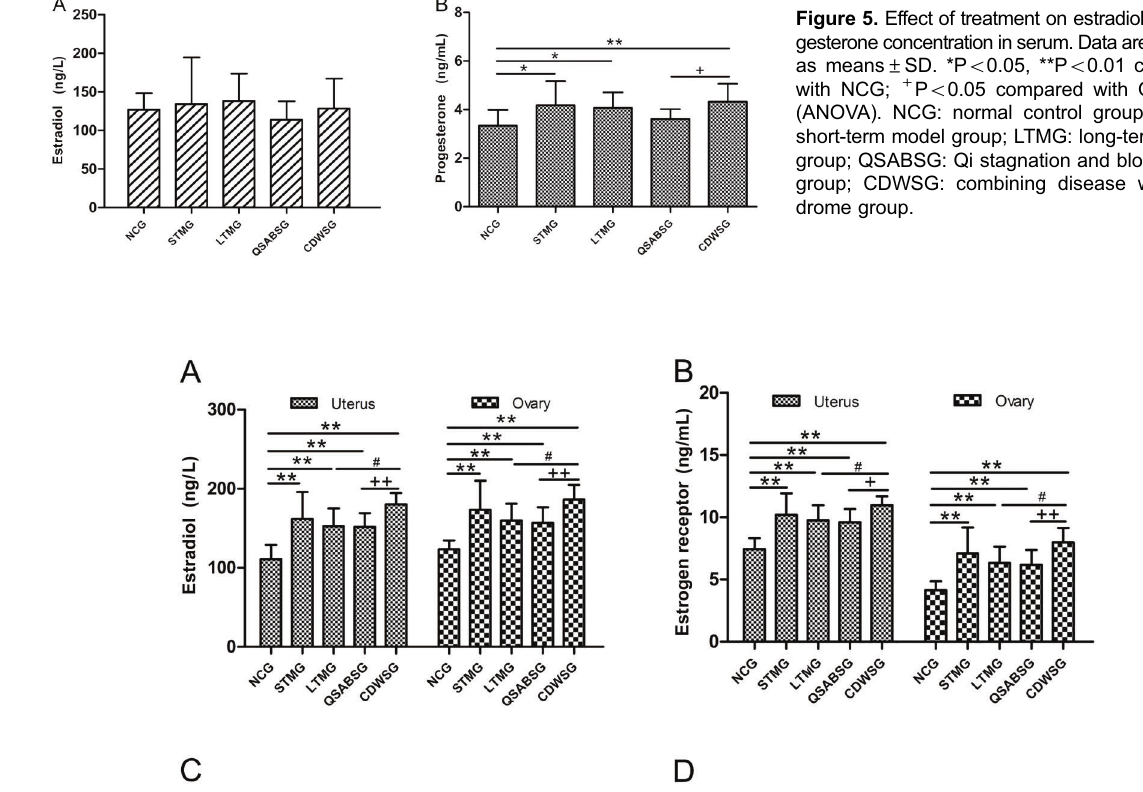
Figure 5. Effect of treatment on estradiol and pro- gesterone concentration in serum. Data are reported as means ± SD. *P o 0.05, **P o 0.01 compared with NCG; + P o 0.05 compared with QSABSG (ANOVA). NCG: normal control group; STMG: short-term model group; LTMG: long-term model group; QSABSG: Qi stagnation and blood stasis group; CDWSG: combining disease with syn- drome group.